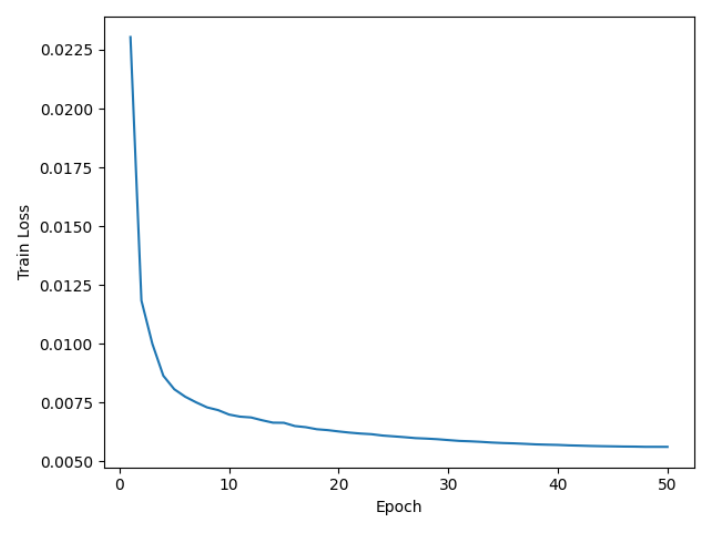
Figure 14. The convergence curve of the proposed SSCANet.